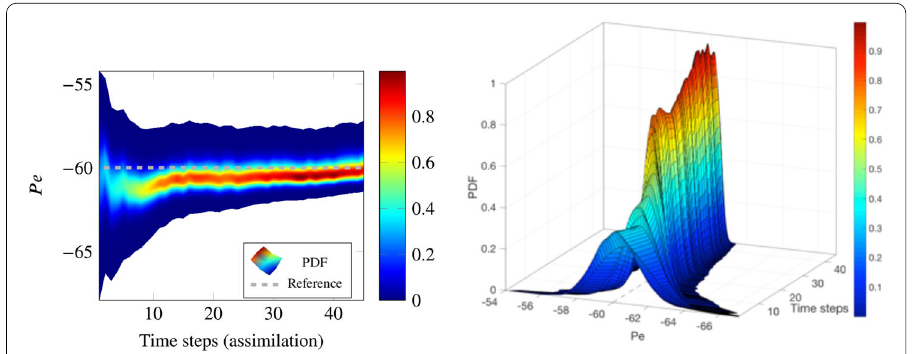
Fig. 12 Marginals on Pe computed with 20,000 samples and kernel density estimation for each assimilation time step - Case 1